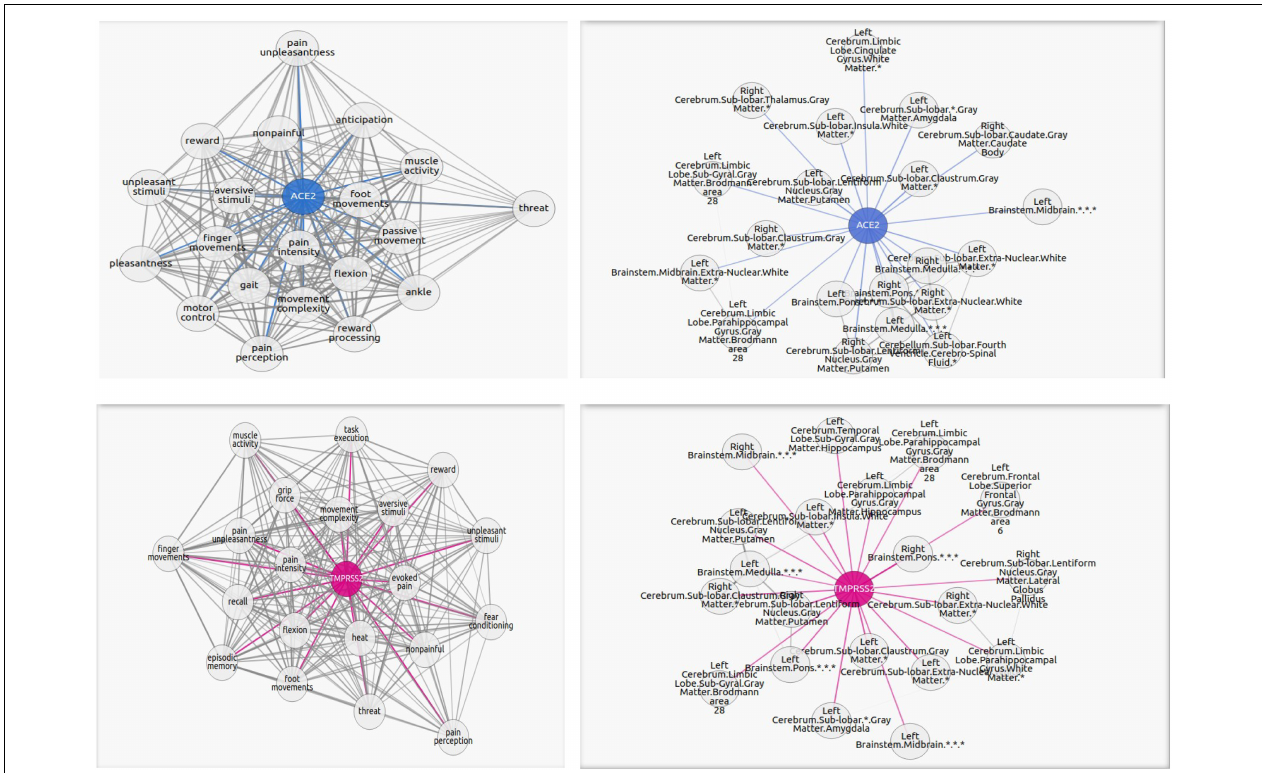
FIGURE 2 | Graphs portraying the regions where the ACE2 (in blue) and TMPRSS2 (in magenta) are the overexpressed and their highest correlated functions. The blue or magenta links connect “ACE2” or “TMPRSS2” network with their correlated tasks. The gray links connect tasks with each other. Each graph shows the 20 most correlated functions/regions. The complete lists of functions and regions are in the Supplementary Materials